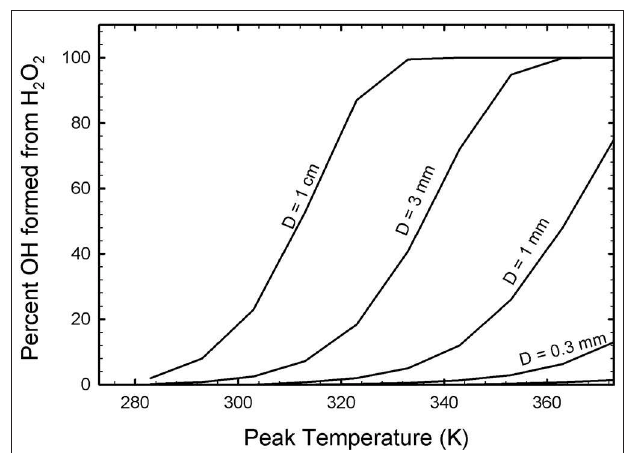
FIGURE 4 | The percentage of H 2 O 2 estimated to break down into OH and OOH radicals via the Fenton reaction as a function of droplet size (diameter as given) and peak temperature, as determined from Equations (x) and (xi). When the droplets are large and collected at high velocity, they heat substantially and cool slowly. As a result, the temperature-dependent Fenton reaction is capable of breaking down significant quantities of H 2 O 2 into OH and OOH.